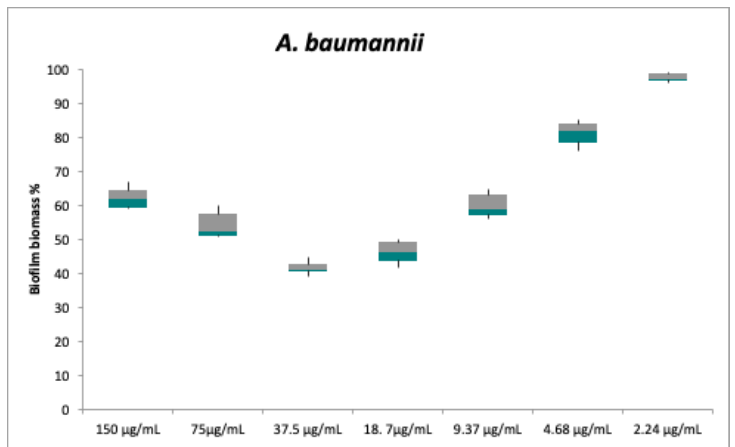
Figure 5. In vitro biofilm formation of A. baumannii following an overnight treatment with serial dilutions of compound 3 . Biofilm formation was determined by the cristal violet assay. Biofilm biomass values are presented as the mean percentage ± SD and A. baumannii biofilm biomass without a treatment is assumed to be 100%. Each pair of means was compared using a Tukey’s multiple comparisons test; no significant differences were detected between the following pairs: 150-9.37 μg/mL ; 37.5-18.7 μg/mL.